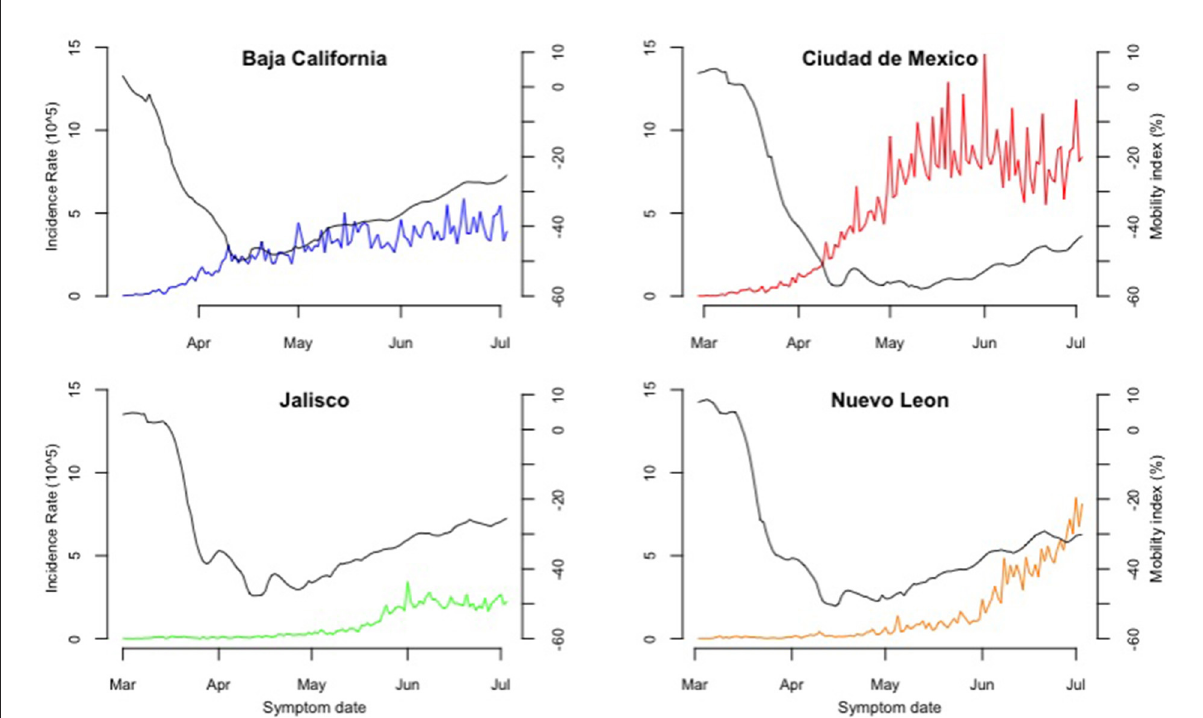
FIGURE3 Incidence rate by symptom onset and mobility index in four states from February 28th to July 3rd, Mexico, 2020. The horizontal axis shows the period covered since the confirmation of the first COVID-19 case in Mexico, February 28th, 2021, to July 3rd 2021. The left vertical axis shows the incidence rate of confirmed cases per 100,000 habitants scale, and the right vertical axis shows the percentage change for mobility on a 10 to − 60% range. The continuous black line represents the average daily mobility rate documented by Google. The colored line shows daily confirmed cases based on their date of symptom